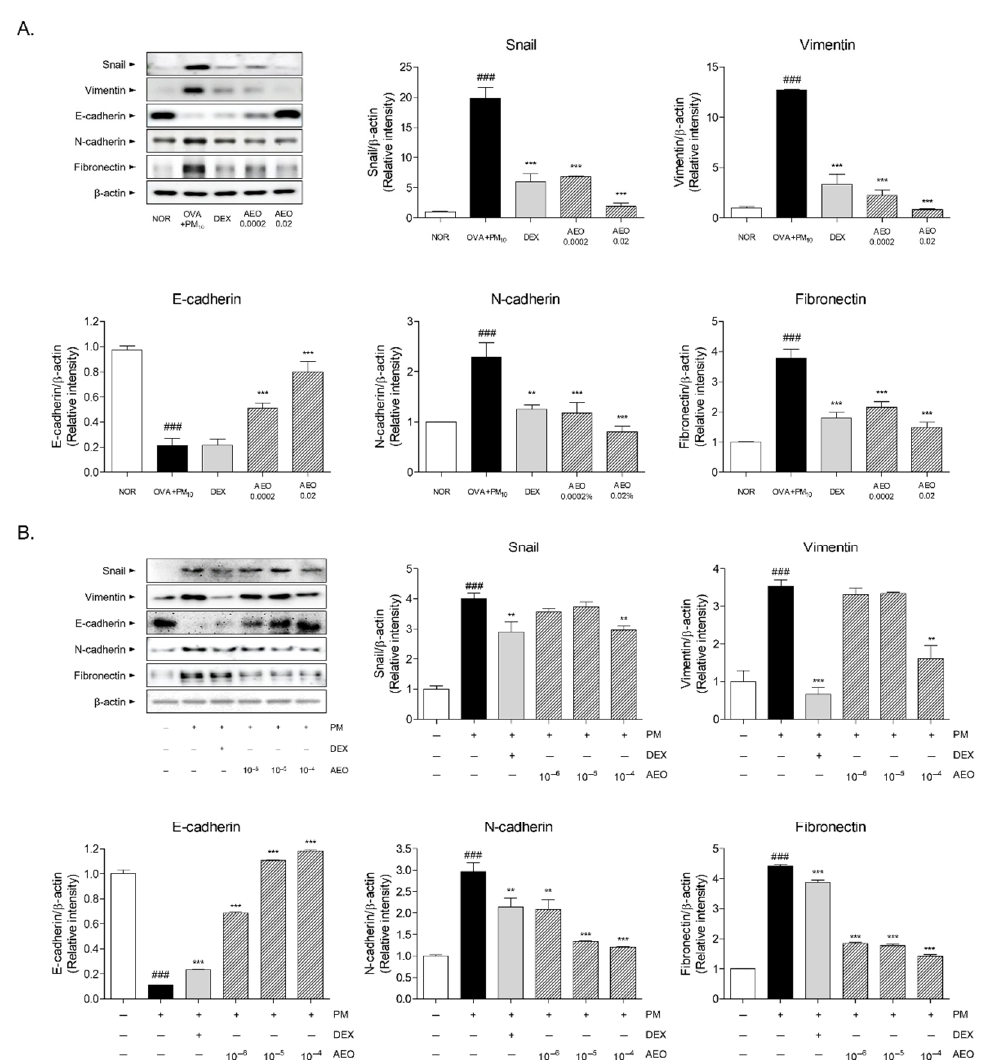
Figure 9. Expressions of epithelial–mesenchymal transition markers including snail, vimentin, E- cadherin, N-cadherin and fibronectin. ( A ) Protein levels of snail, vimentin, E-cadherin, N-cadherin and fibronectin with quantified values in lung tissues. Results are presented as mean ± standard error of the mean. ### p < 0.001 vs. NOR group; ** p < 0.01 and *** p < 0.001 vs. OVA+PM 10 group. ( B ) Protein levels of snail, vimentin, E-cadherin, N-cadherin and fibronectin with quantified values in A549 lung epithelial cells. Results are presented as mean ± standard error of the mean. ### p < 0.001 vs. non-treated cells; *** p < 0.001 vs. PM 10 -stimulated